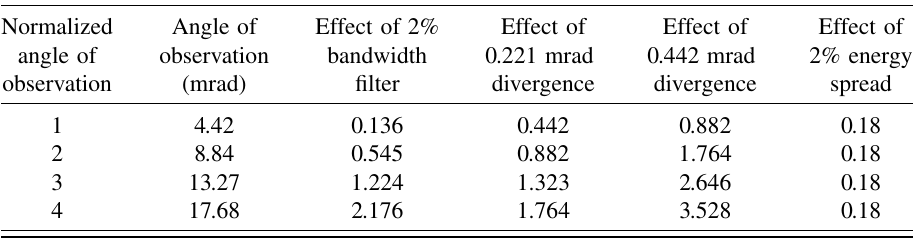
TABLE I. Variation of phase terms calculated for the JLAB experimental parameters.